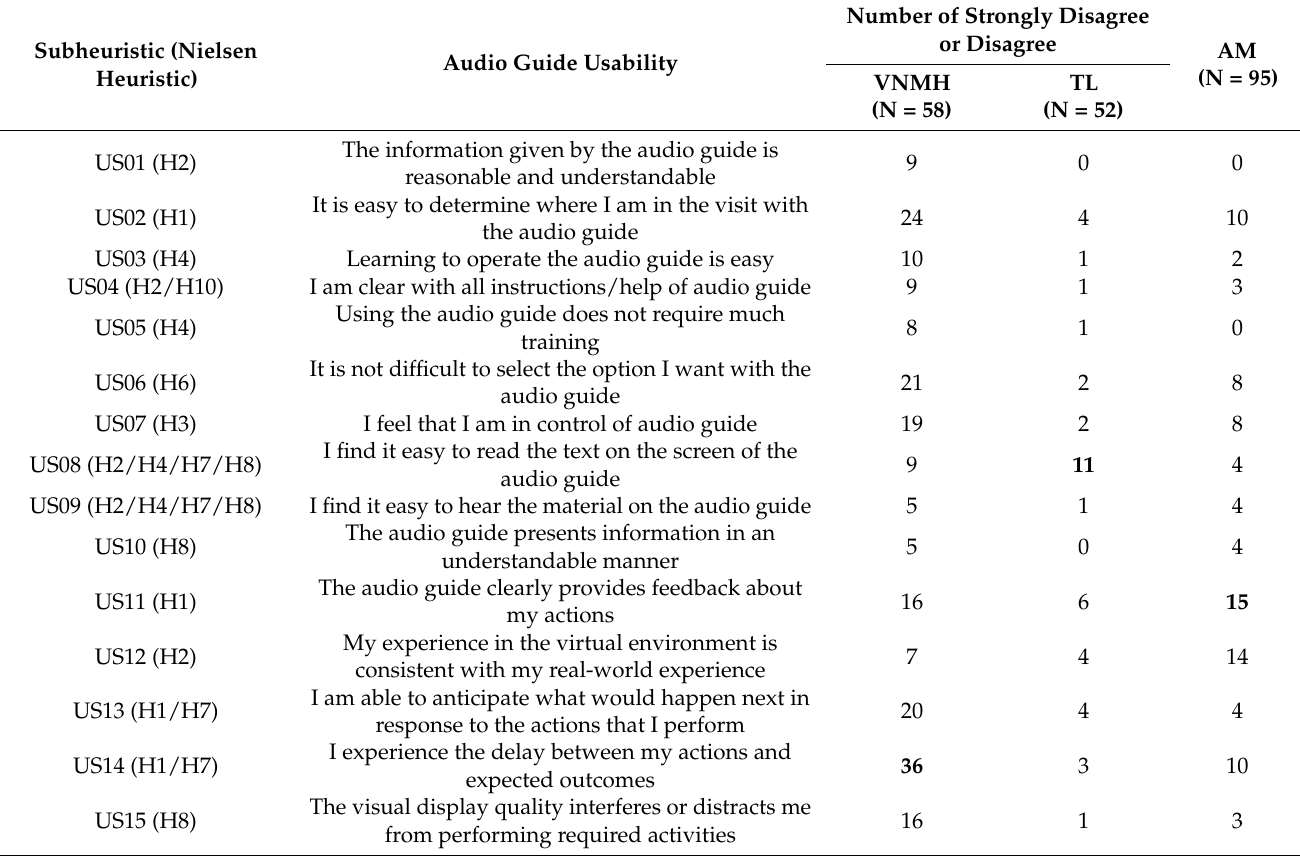
Table 4. Usability evaluation of audio guides (bold values represent the highest number of Strongly Disagree or Disagree in each